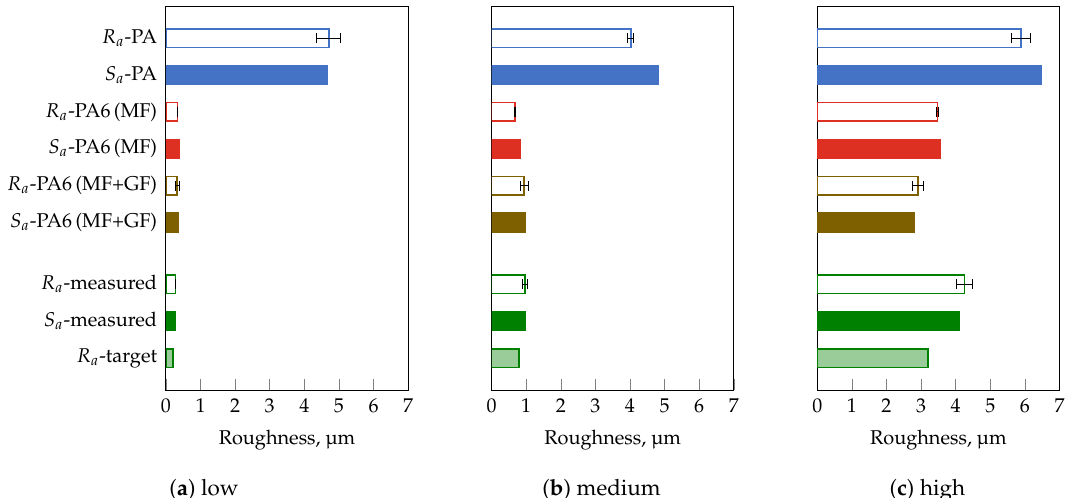
Figure 4. Measured surface S a and line roughness R a values are equal to each other as long as no sample curvature is present. In addition, the impression quality is significantly influenced by the thermoplastic material. Measurement range of 2 mm × 2 mm for S a and according to ISO4288 [37] for R a . Mineral filler (MF) and glass fiber (GF). Deployed insert with a target line roughness of ( a ) 0.2 µ m (low), ( b ) 0.8 µ m (medium), and ( c ) 3.2 µ m